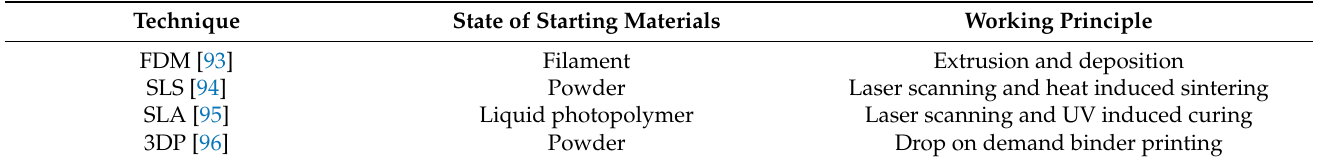
Figure 7. Schematic diagram of typical 3D printing [93]: ( a ) FDM; ( b ) SLA; ( c ) SLS. Table 5. Established rapid prototyping